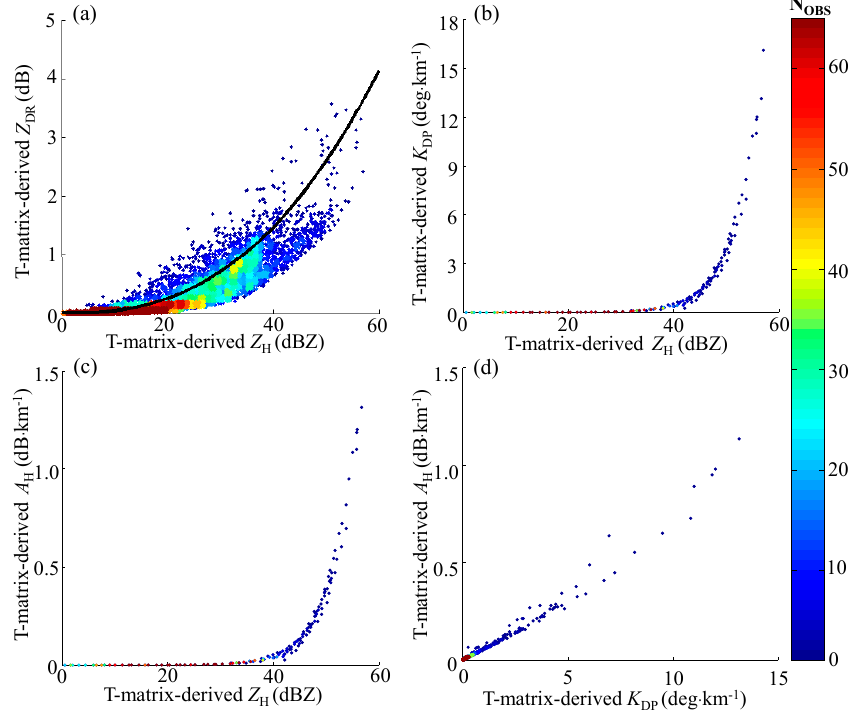
Figure 3. Scattergram of radar variables simulated using the DSD dataset collected on 0000–2359 UTC on 01 June 2016: ( a ) Z DR vs. Z H ; ( b ) K DP vs. Z H , ( c ) A H vs. Z H , and ( d ) A H vs. K DP . The black curve in (a) represents the Z DR – Z H relationship in Equation (2a).